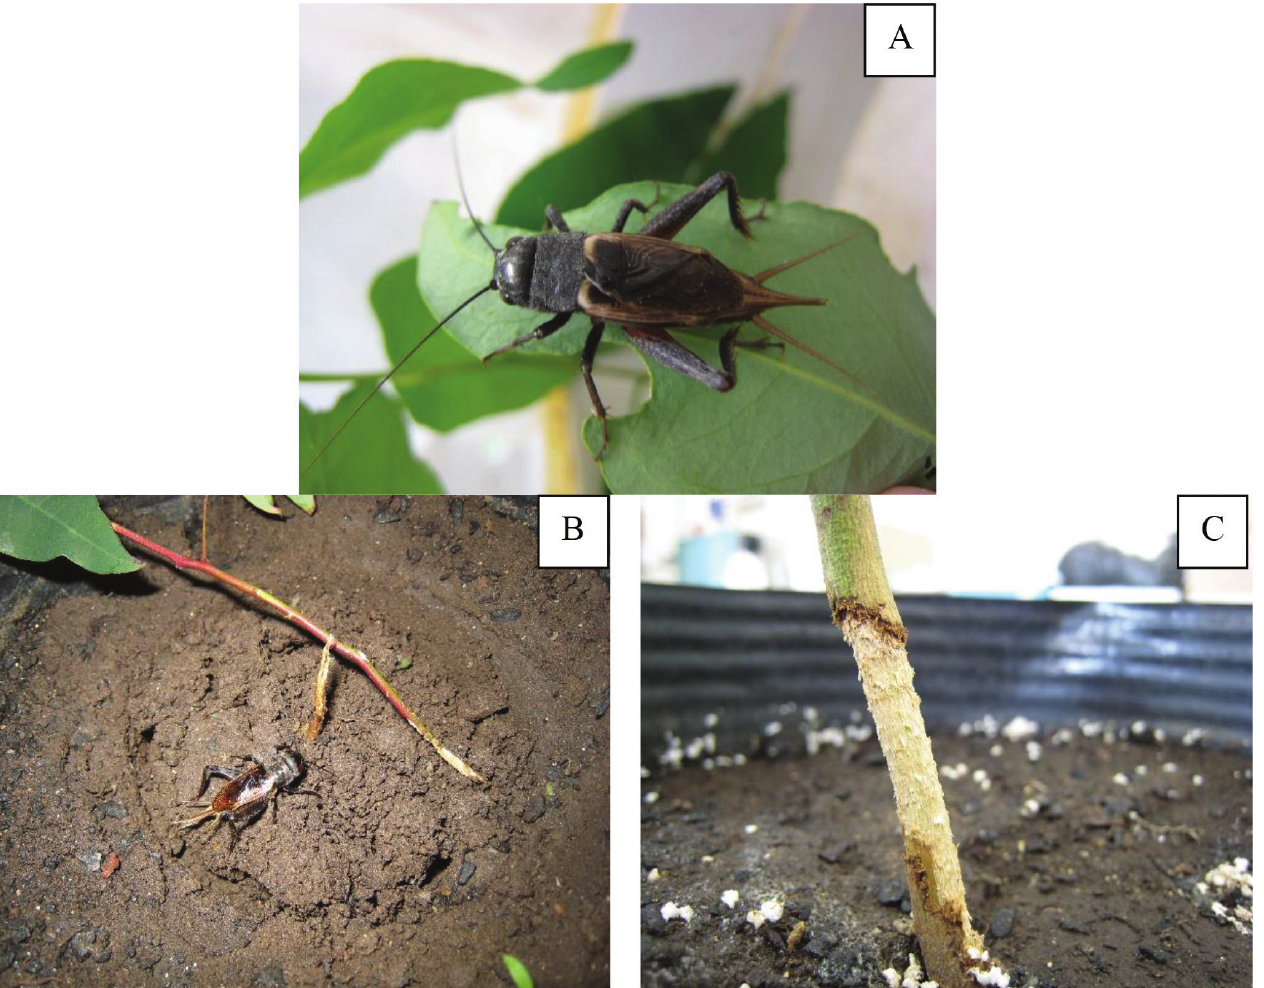
Fig. 2. Gryllus assimilis (Orthoptera: Gryllidae). A . Adult; B, C . Damage to Eucalyptus sp.